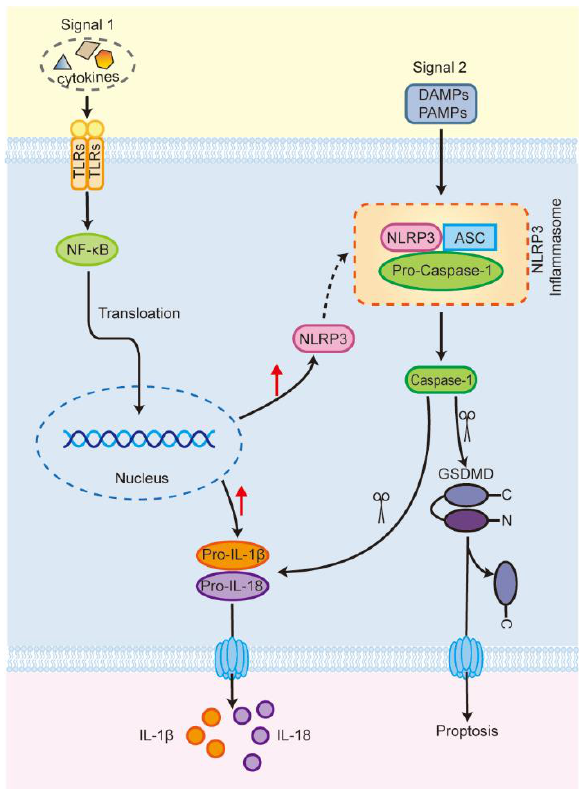
Figure 1. The activation process of NLRP3 inflammasome (Scissors represent clipping; red arrows represent rising). TLRs, toll-like receptors; NF- κ B, nuclear factor kappa-B; NLRP3, nod-like receptor protein 3; Pro-IL-1 β , pro-interleukin-1 β ; Pro-IL-18, pro-interleukin-18; ASC, apoptosis-associated spotted protein; Pro-caspase-1, pro-cysteine aspartate protease 1; GSDMD, gasdermin D. Biologists have long regarded cell death as an inevitable, passive outcome of life.